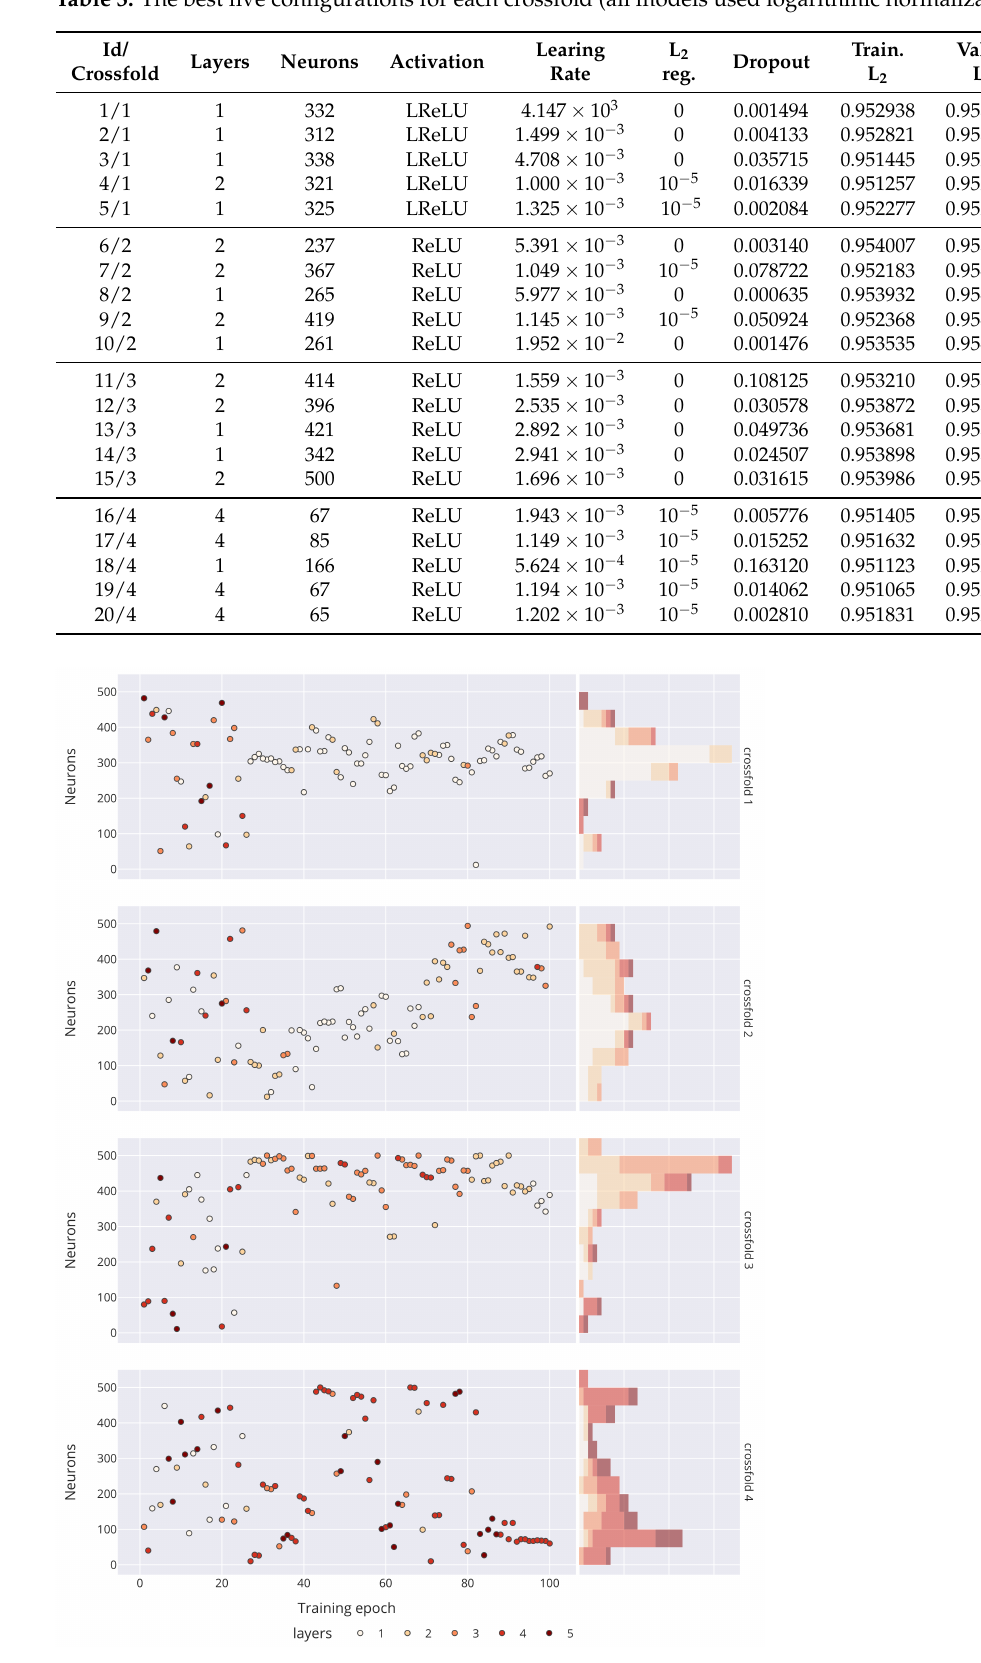
Figure 3. Changes in number of layers and neurons during trials for each